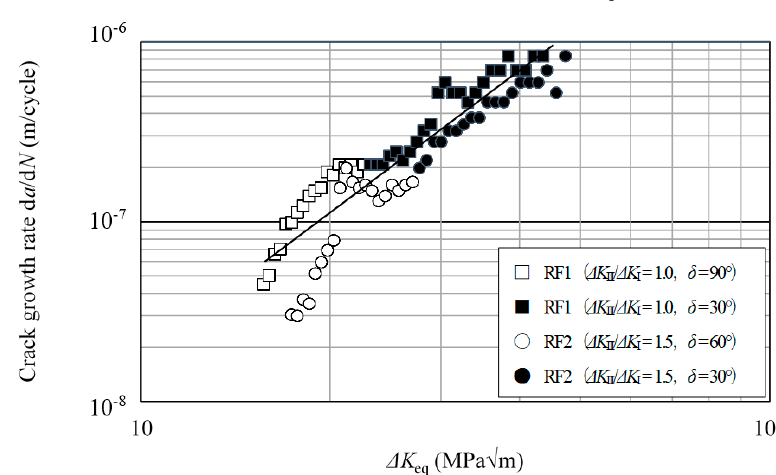
Figure 12. Branch crack growth rate against Δ K eq for RF.